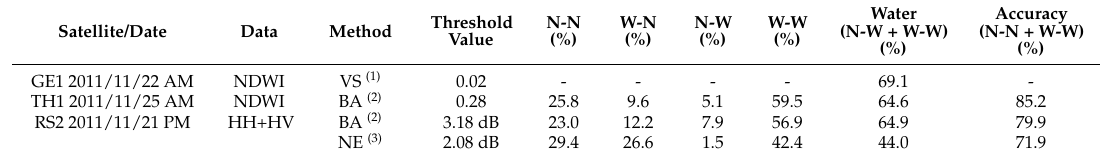
Table 3. Results of the accuracy assessment of the water extraction for Ayutthaya